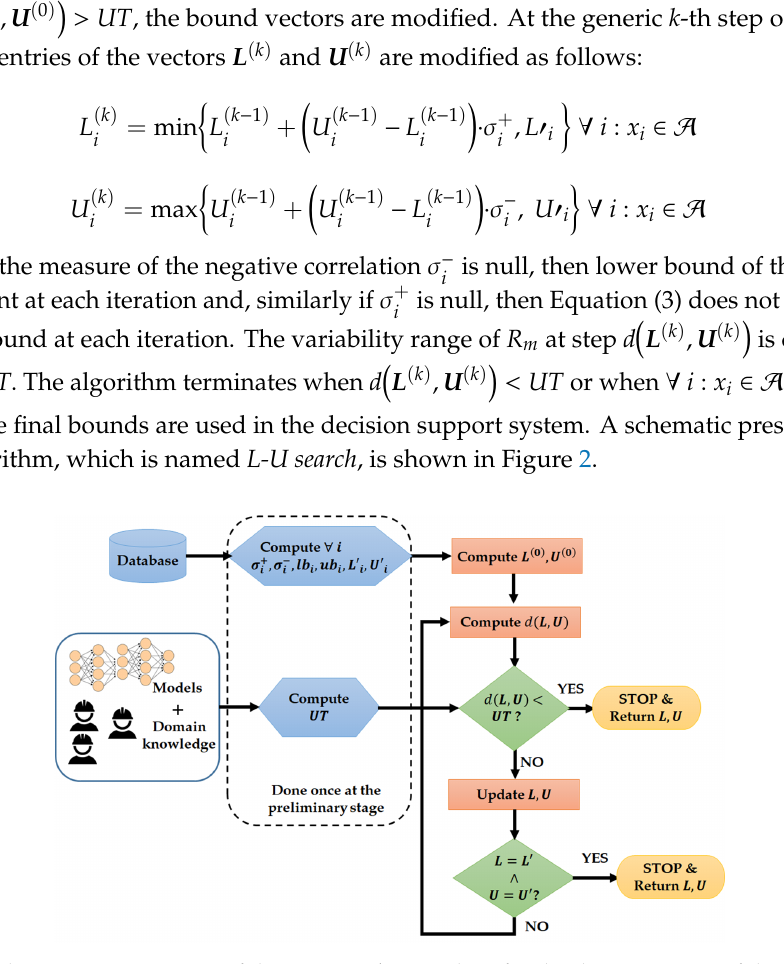
Figure 2. Schematic presentation of the L-U search procedure for the determination of the variability bounds of relevant process variables.